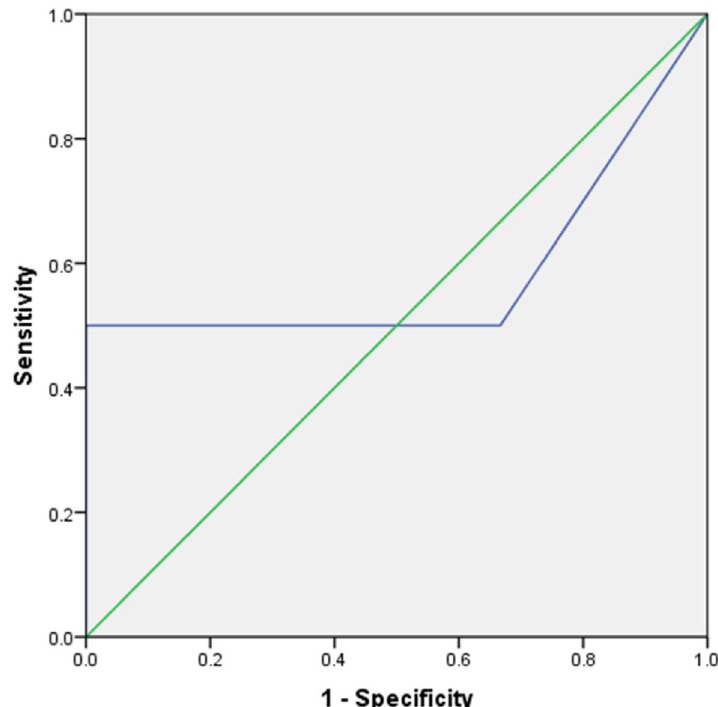
Fig. 3 Receiver operating characteristic (ROC) curve of PC2 model of serum individual bile acids for differentiating between BA and non‑BA